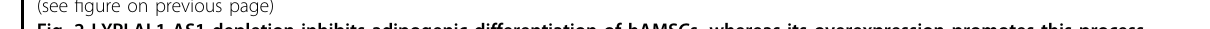
(Fig. 4b, left) and 146 speci fi c U1-binding proteins (Fig. 4b, right) from this assay.